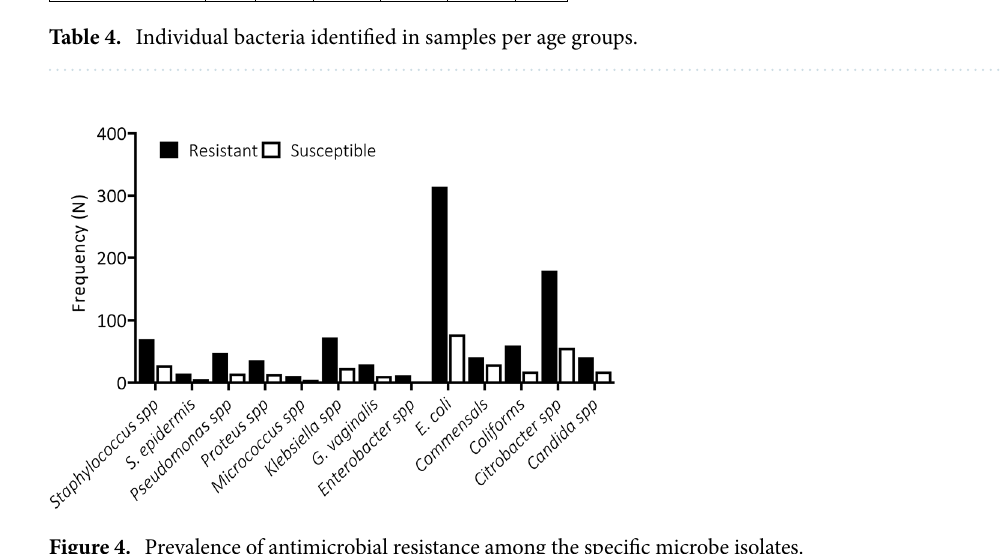
Figure 4. Prevalence of antimicrobial resistance among the specific microbe